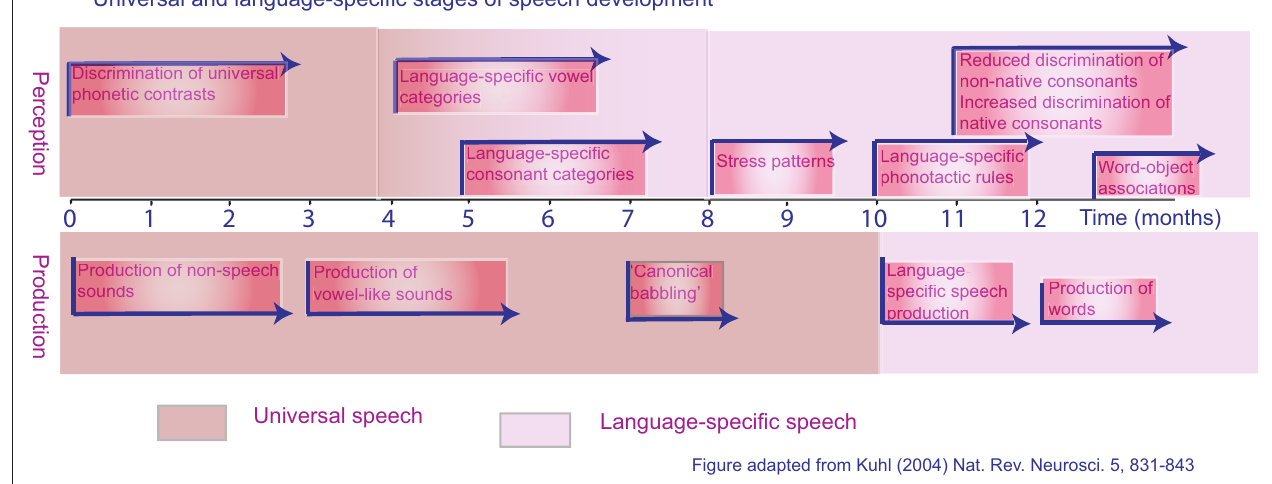
FIguRe 1 | universal and language-specific stages of development for speech perception and speech production in typically developing human infants from birth to 1